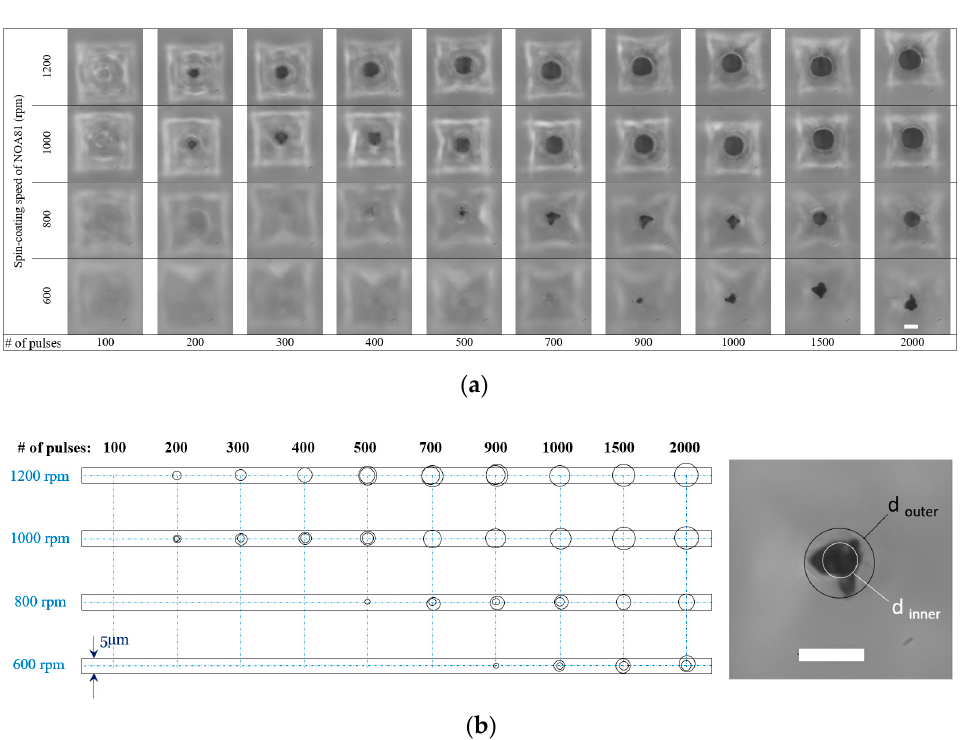
Figure 8. ( a ) The view of the openings on the bottom side of four different NOA81 microsieves. Each has been made with a specific spin-coat speed, which are 600, 800, 1000, and 1200 rpm. On each foil, 14 micropores were realized (selected ones are presented here) with an increasing number of pulses but all with 150 Hz. The scale bar located in the lower right image is 5 µm for all images. ( b ) Spread of the inner and outer diameter of the aperture plotted for each microsieve for an increasing number of laser pulses (the representation of the inner and the outer diameter of a projected circle onto the resulting shape defines the